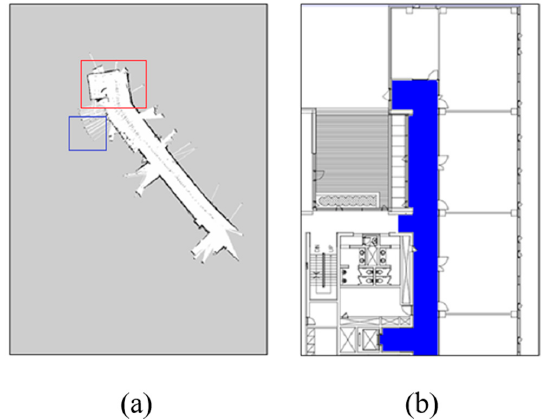
Figure 4. Example of collecting the occupancy grid map (OGM) of the test bed: ( a ) result of the OGM generation; ( b ) corresponding area.